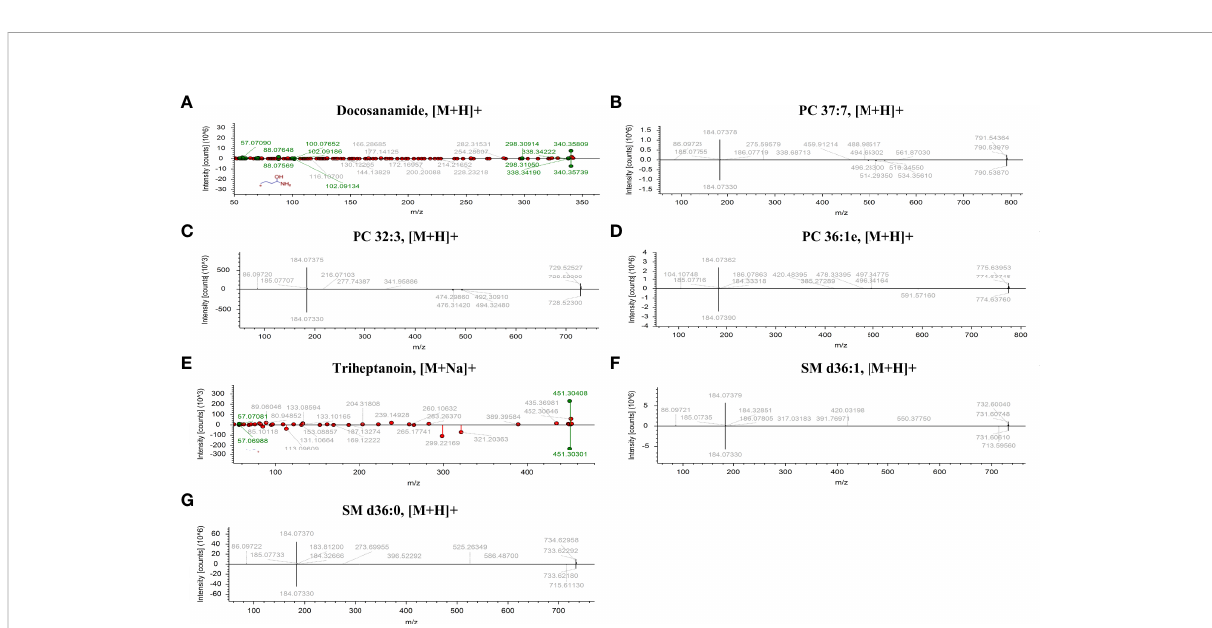
FIGURE 7 The identi fi cation of seven differential lipid species with high discriminate performance for CA and CRC. Differential lipids between CA and CRC including Docosanamide (A) , PC 37:7 (B) , PC 32:3 (C) , PC 36:1e (D) , Triheptanoin (E) , SM d36:1 (F) , and SM d36:0 (G) were preliminarily identi fi ed with the adduct forms of [M+H]+ and